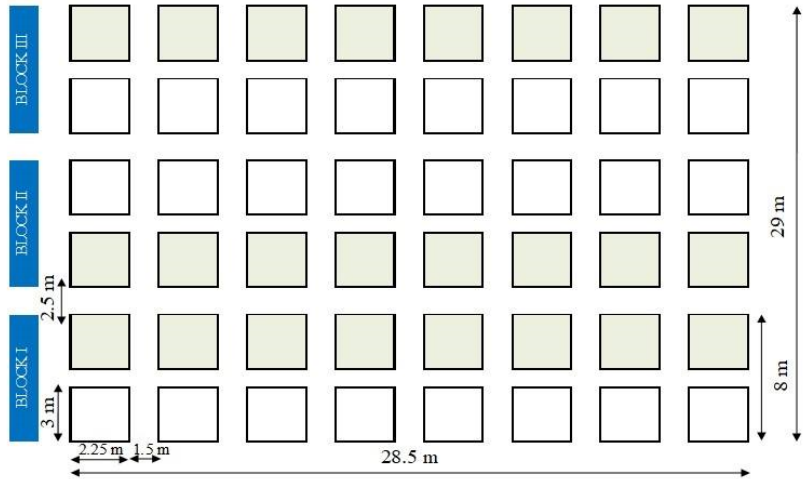
Figure 7. Experimental layout using split-plot design in the study area.